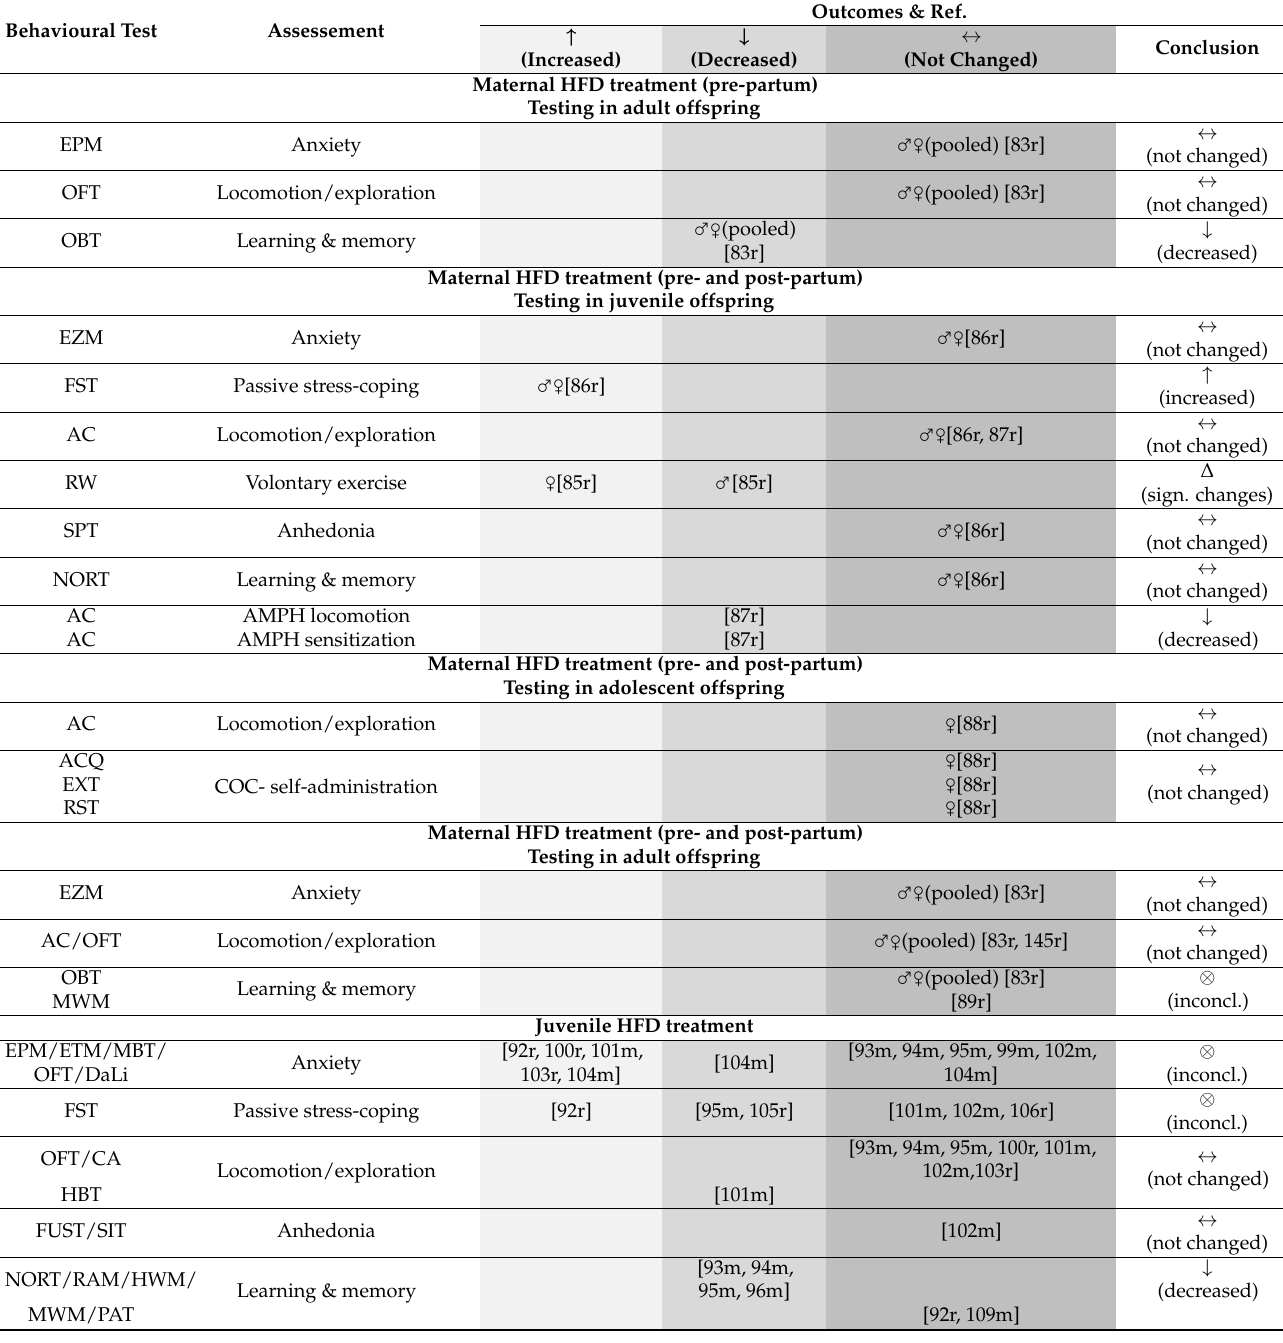
Table 1. Literature overview of the impact of a high-fat diet treatment on emotionality, cognition and reward-related behaviours in rodents, taking into account the developmental period. Description: Studies are organised by the developmental period (i.e., before puberty or early adolescence, during late adolescence or in adulthood) in which the high-fat diet (HFD) treatment was applied. For the effects of a maternal HFD treatment, studies are organised by the developmental period (i.e., before puberty or early adolescence, during late adolescence or in adulthood) in which the offspring were tested. All studies reviewed used male ( ) mice (m) or rats (r), otherwise indicated by the female ( ) ♀ ♂ symbol. The numbered references refer to the bibliography